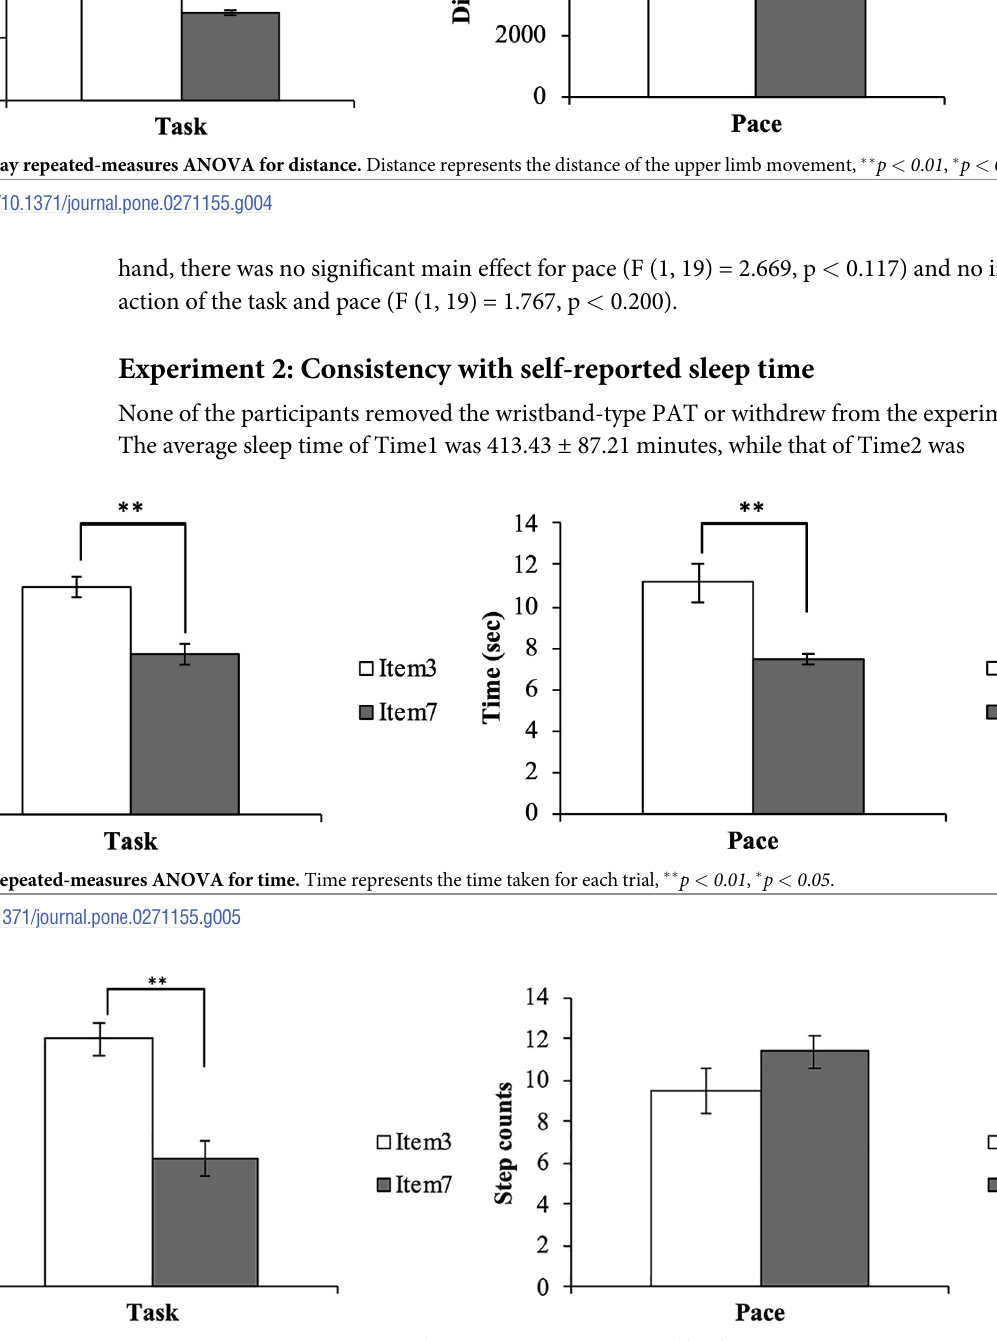
PLOS ONE | https://doi.org/10.1371/journal.pone.0271155 July 8,